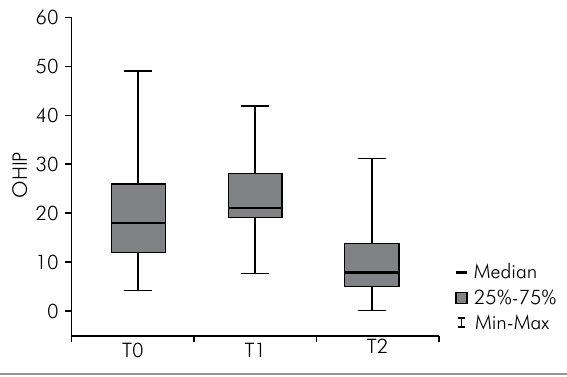
Figure. Minimum and maximum scores simulating the median line seen at each separate time period.